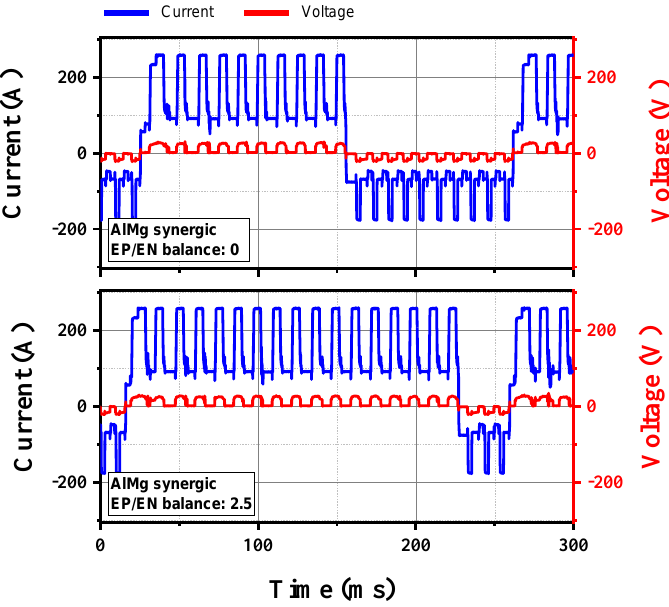
Figure 4. Measured waveform utilizing AlMg5 synergic line.